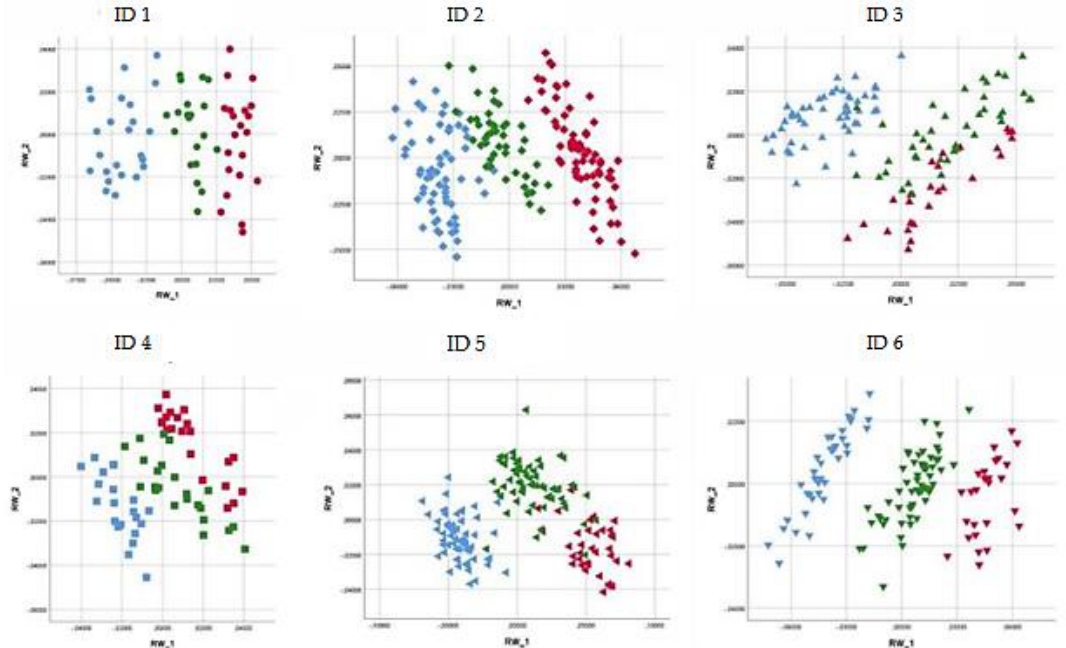
Figure 7. Scatterplot of the first two relative warp scores (RWs) considering the back posture of each individual horse. The three different colors describe the data obtained for three different feeding positions: red, on the ground—control position (CP); green, neck held 15 ± 3° below withers height with low hay net position (LP); and blue, neck held 15 ± 3° above withers height with high hay net position (HP). Principal component analysis (PCA) based on the first two RWs (RW 1 and RW 2) describes the percentage of the overall shape variation: 92.89% for ID 1; 97.02% for ID 2; 95.89% for ID 3; 87.04% for ID 4; 95.71% for ID 5; and 92.78% for ID 6.